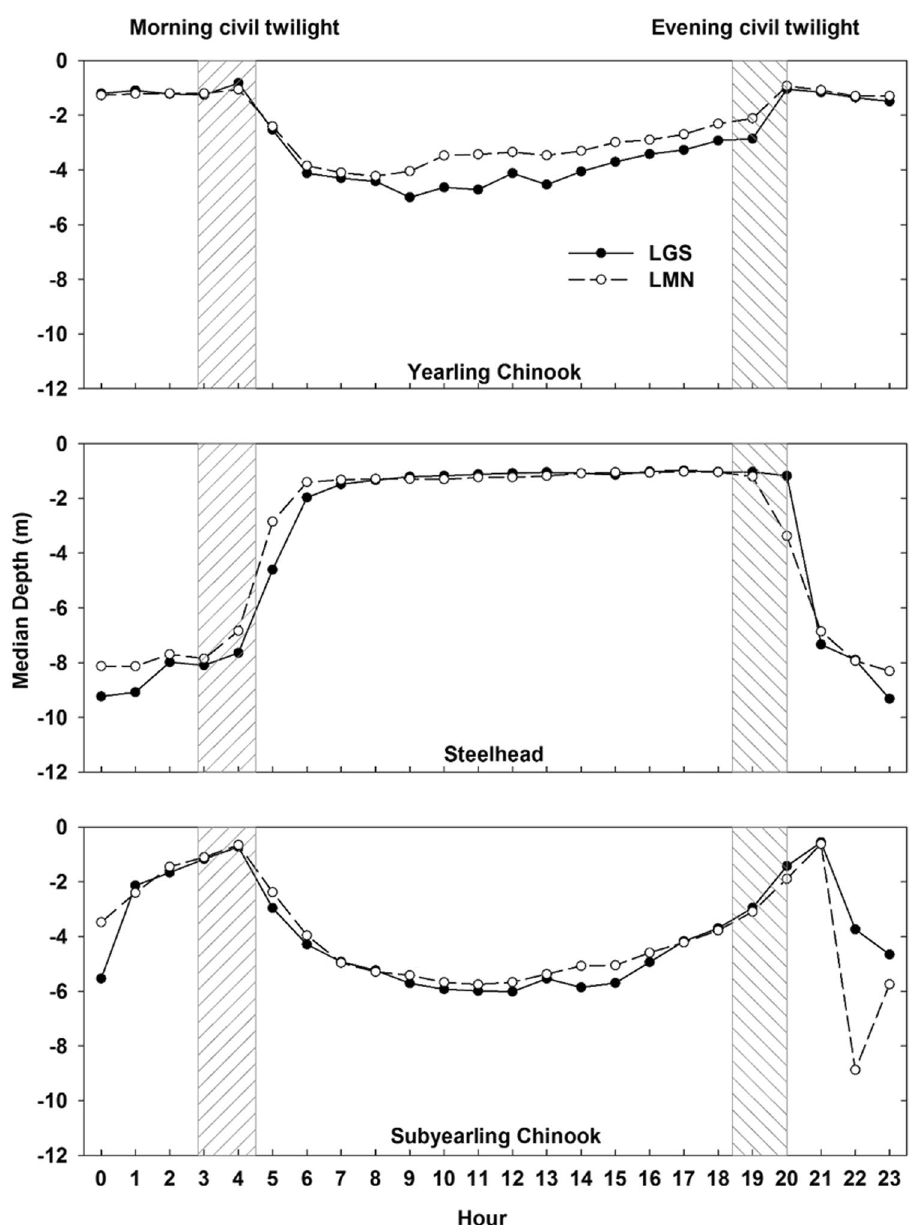
Figure 6. Median depth of acoustic tagged yearling Chinook salmon (Top), steelhead (Middle) and subyearling Chinook salmon (Bottom) in each hour of the day that juvenile fish were detected within 75 m of the dam face in the forebays of LGS and LMN during 2012. The dashed areas represents the two periods of civil twilight varying from April to August,